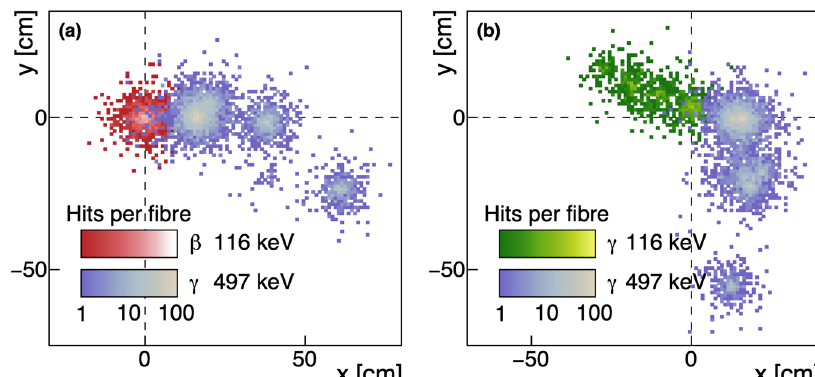
Fig. 4 Combining LiquidO with 115 In to enable low-threshold electron neutrino measurements. At an energy of greater than 114 keV electron neutrinos undergo a charged current (CC) interaction on 115 In, which could be added as a dopant at high concentrations to a LiquidO detector. The e − produced has an energy proportional to the original neutrino and the excited 115 Sn* nucleus decays in delayed-coincidence with τ = 4.76 μ s. The two plots show a LiquidO simulation of the number of photons hitting each fi bre in a 1-cm-pitch lattice for the two possible decay modes of 115 Sn*. In both cases a 497 keV γ is produced together with either an e − ( a ) or a γ ( b ) at 116keV. The colour of each point in the images represents the number of photons hitting a fi bre at that x - y location. The energy deposit of the prompt e − is not shown in the plots but provides the time and space coordinates to look for the mono-energetic tin decay in delayed-coincidence. Furthermore, the high-resolution images enable ef fi cient background rejection by requiring a point-like energy deposition of the e − to be followed by the spatially dispersed Compton-scattering pattern of a γ . This distinct signature that arises from combining indium with a LiquidO detector exempli fi es the potential of the